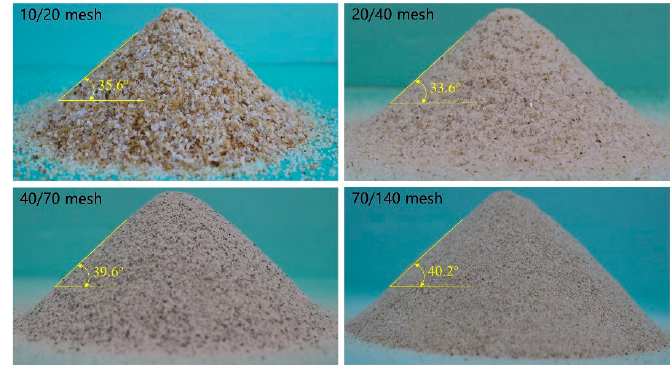
Figure 4. Particle samples used in experiments.